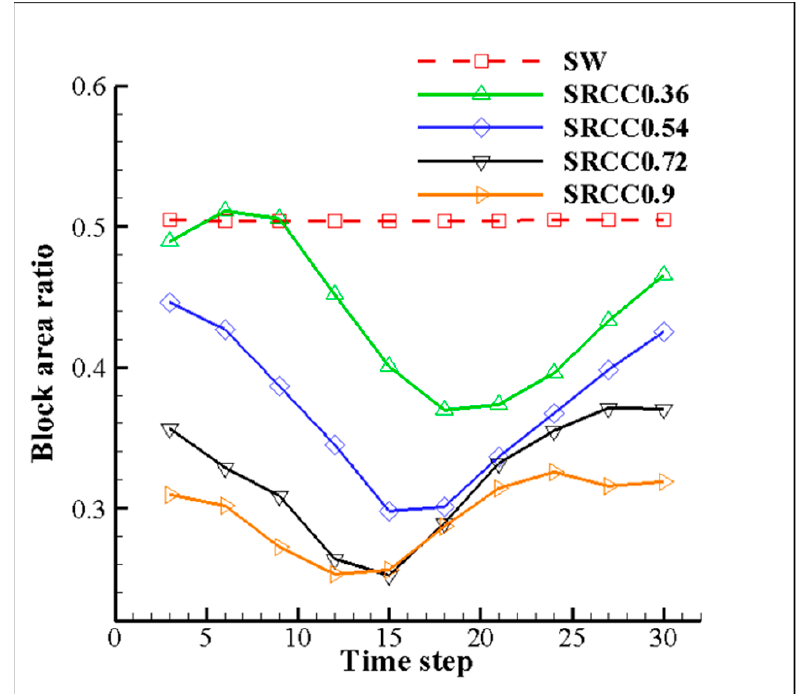
Figure 20. Changes in the blockage ratio under different self-circulating casings at 50% τ . The meridional dimensionless radial velocity contours in and under four self-circulating casings were determined (Figure 22). The radial velocity selected in contours represented the circumferential average value of unsteady time-average simulation results, and the dimensionless radial velocity was equal to the ratio of the local radial velocity to the average axial velocity at the inlet. The numbers in the contours show the dimensionless radial velocity value at that location, and a positive value indicates an upward direction. The results showed that the absolute dimensionless radial velocities at the suction and inject port of four self-circulation casings were relatively large. The red area with the largest absolute value of radial velocity increased with an increase in the circumferential coverage ratio, indicating that the upward radial velocity at the suction port was proportional to the circumferential coverage ratio. The blue area corresponds to the downward radial velocity at the inject port, and a larger area indicates a greater and more extensive downward radial velocity. The contours show that the downward radial velocity at the inject section increased with an increase in the circumferential coverage ratio, and the area had a positive effect. The downward radial velocity area under the inject port increased with an increase in the circumferential coverage ratio, implying that a larger circumferential coverage ratio was correlated with a large velocity and the area occupied by the jet. (Figure 23). The abscissa represents the circumferential coverage ratio, and the ordinate represents the dimensionless suction and inject mass flow rate based on the compressor design mass flow rate. The results showed that a large circumferential coverage ratio was correlated with a large mass flow rate through the suction and inject port of the